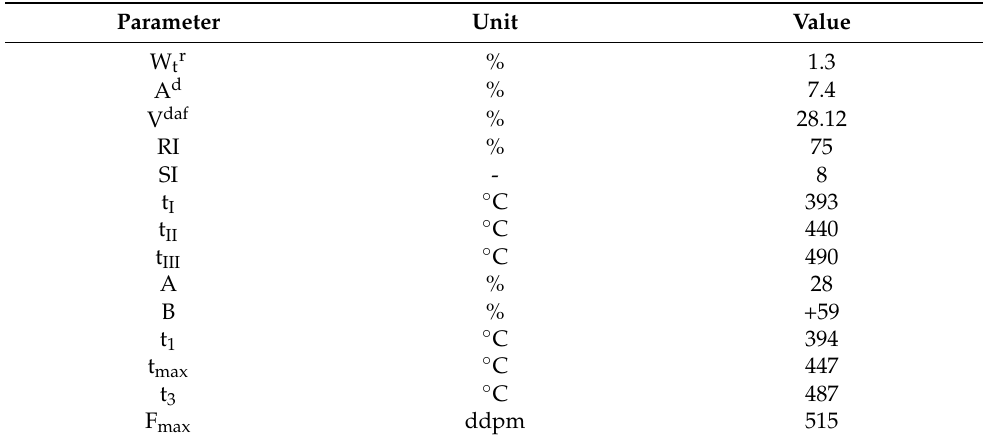
Table 5. Coking properties of coal blend with a constant qualitative composition with moisture content W r = t